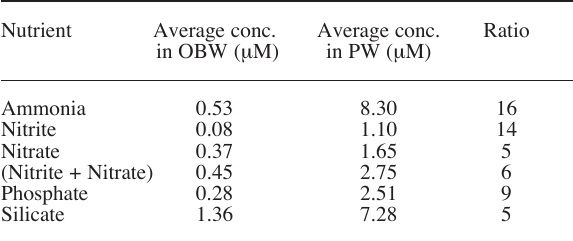
F IG . 4. – Average nutrient fluxes (µmol m -2 d -1 ) from the sediments pore waters (PW) to the water column calculated for NH 4+ , NO 2- + NO HPO 4-2 and